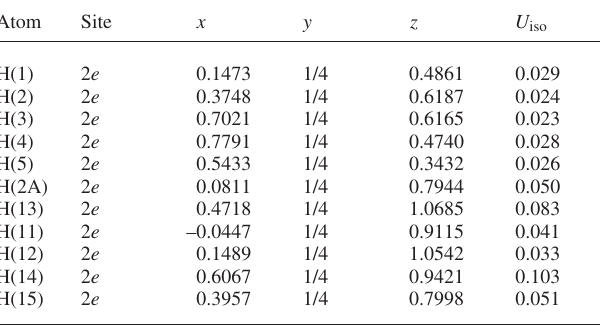
Table 2. Atomic coordinates and displacement parameters (in Å 2 )